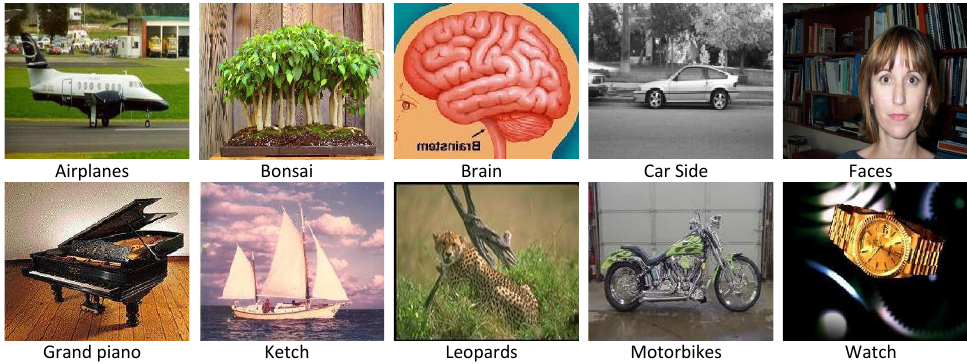
Figure 9. Sample image of each semantic category of Oxford Flower-17